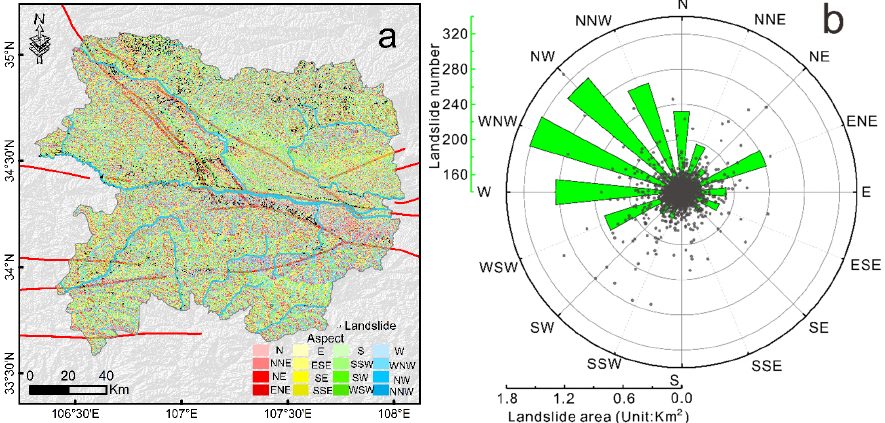
Figure 10. ( a ) Aspect (slope-facing direction) distribution in the study area. ( b ) Landslide distribution in respect to aspect and landslide area.